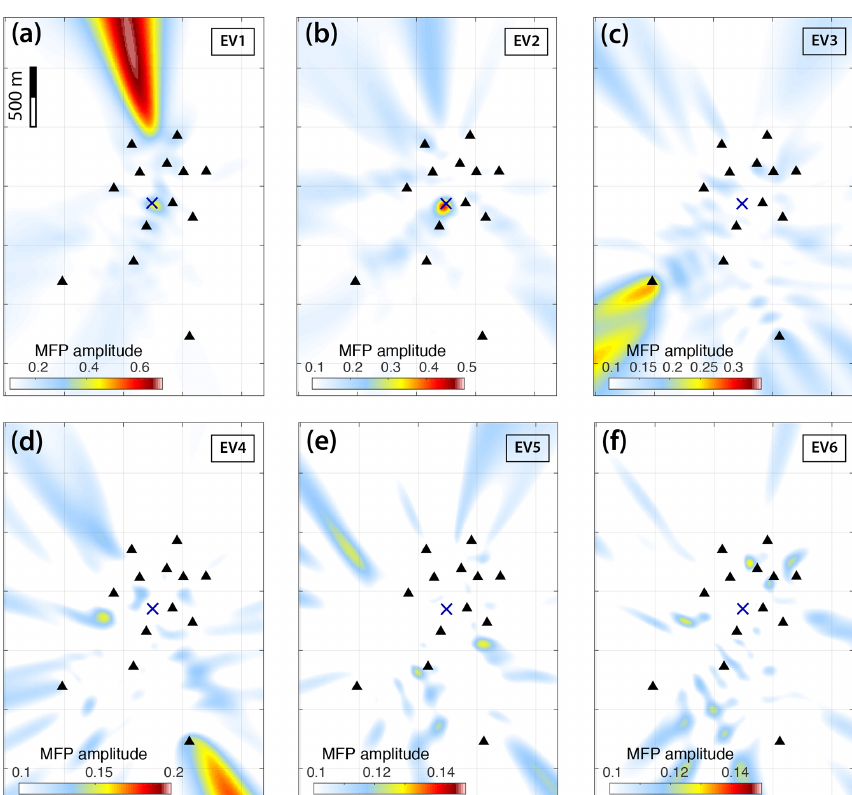
Figure 8. Reconstruction of the CSDM by using individual eigenvectors (EVs) that are related to different noise sources. Each plot shows MFP output computed using the reconstructed CSDM with individual eigenvectors as in Eq. (3). Each figure represents the MFP grid-search output calculated for the first eigenvectors: (a) 1, (b) 2, (c) 3, (d) 4, (e) 5, and (f) 6. The spatial coordinates are the same as in Fig. 7a. The blue cross indicates the moulin